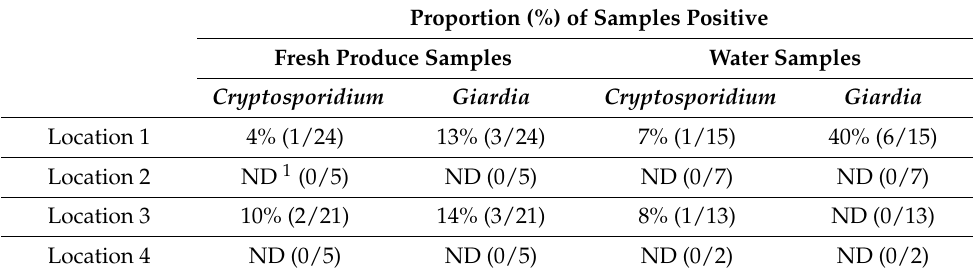
Table 3. Occurrence of contamination of fresh produce with Cryptosporidium and Giardia oo(cysts) compared with water in the same